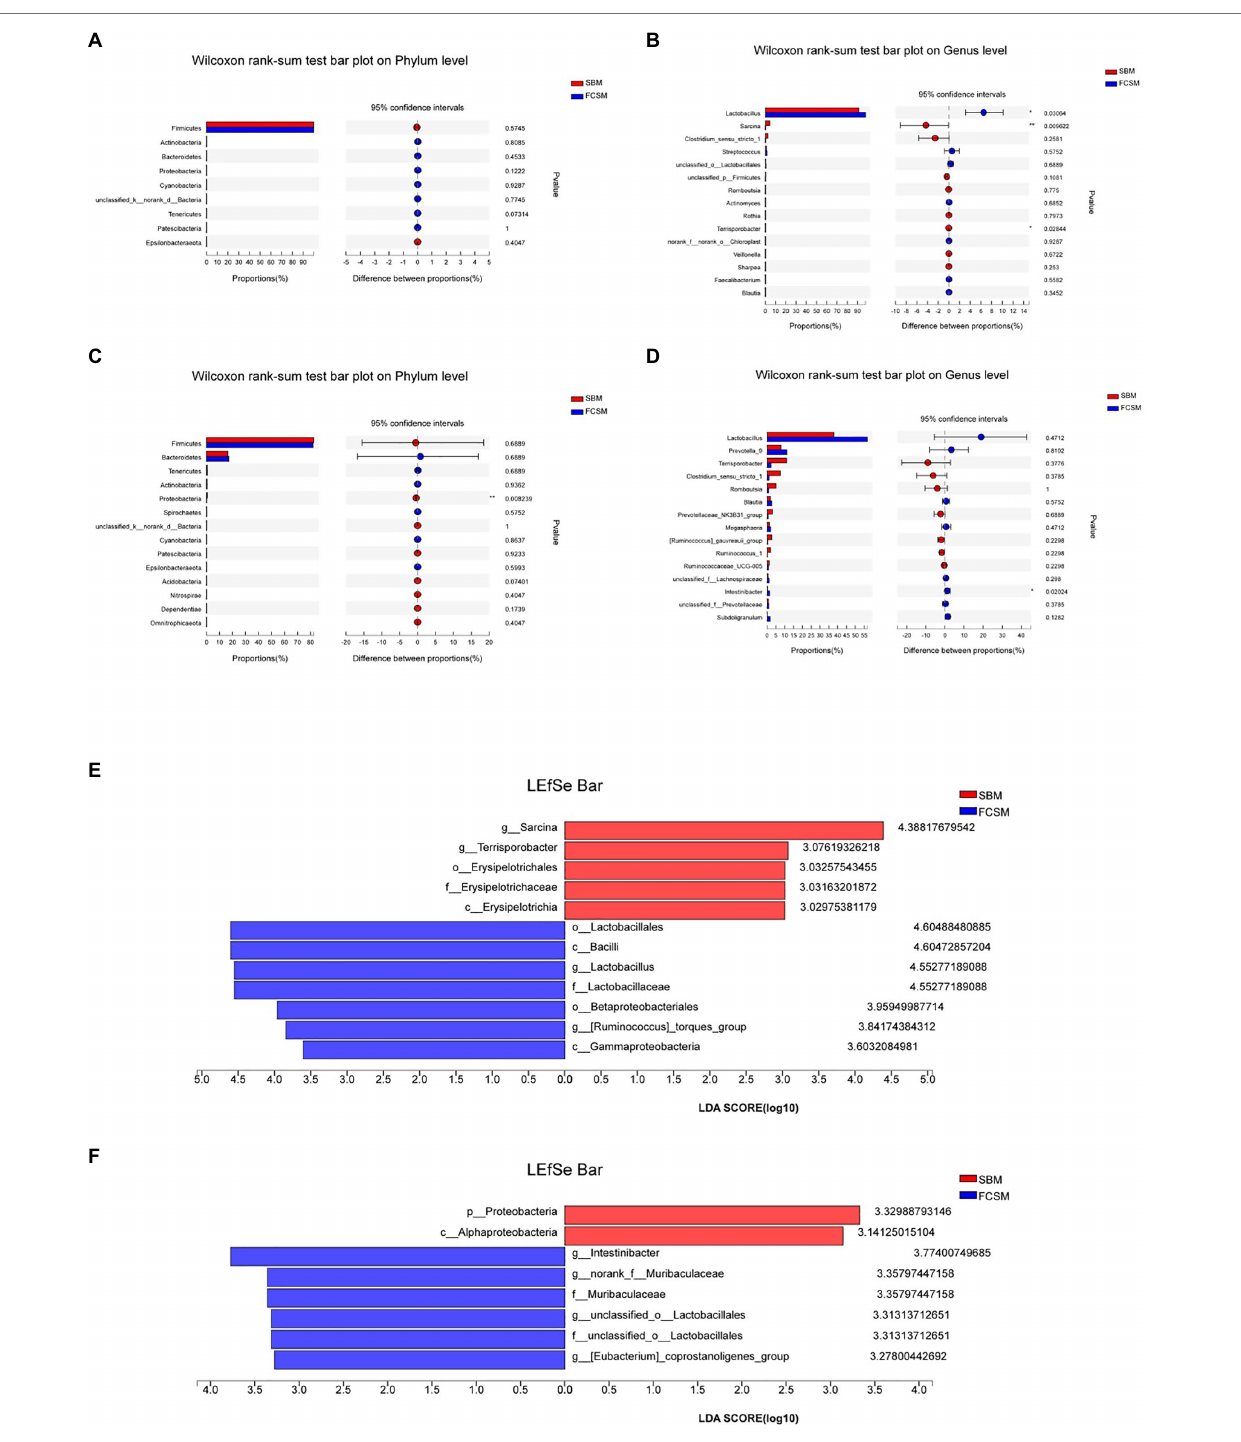
FIGURE 3 | Different microbiota comparison by the student t -test on Phylum and Genus of ileum (A,B) and cecum (C,D) was shown in (A–D) . LDA effect size analysis (LEfSe) analysis showed significantly changed bacteria between SBM and FCSM group in ileum (E) and cecum (F) . The individual minipig was regarded as the experimental unit ( n = 6). SBM, soybean meal; FCSM, fermented cottonseed